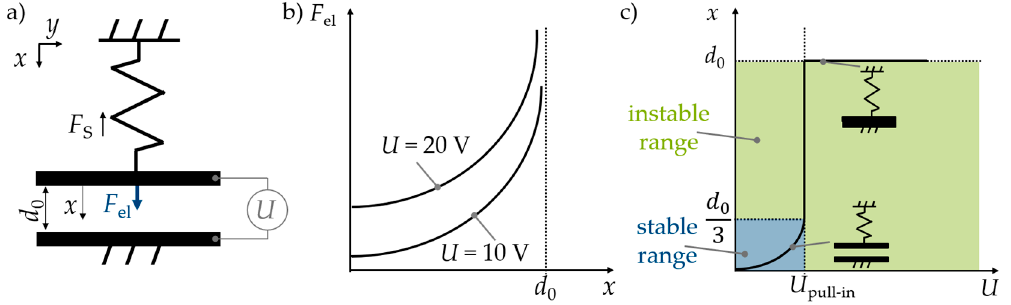
Figure 7. ( a ) Setup of an electrostatic parallel-plate actuator, ( b ) exemplary force–displacement characteristic curve, ( c ) exemplary electrode displacement depending on the applied voltage.